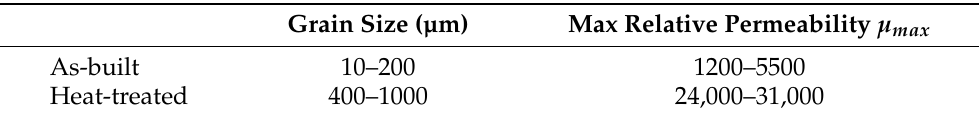
Table 1. Comparison of grain size and maximum relative permeability between as-built and heat- treated printed soft magnetic materials [34,37,40,43,45].